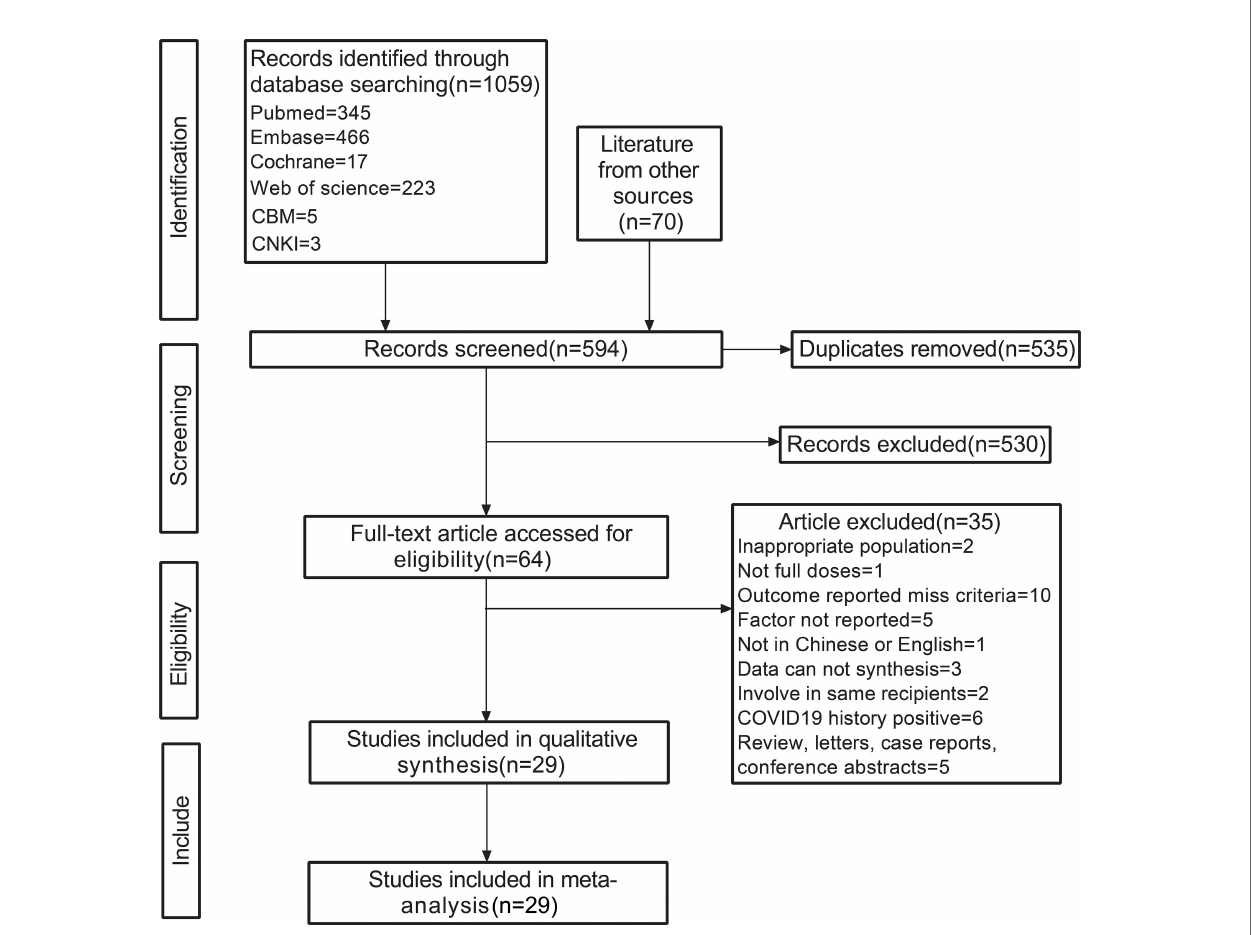
FIGURE 1 | Flow chart depicting the study inclusion and exclusion processes. CNKI, China National Knowledge Infrastructure; CBM, Chinese Biomedical Literature Database; other sources, literature collected in other ways before conducting the systemic